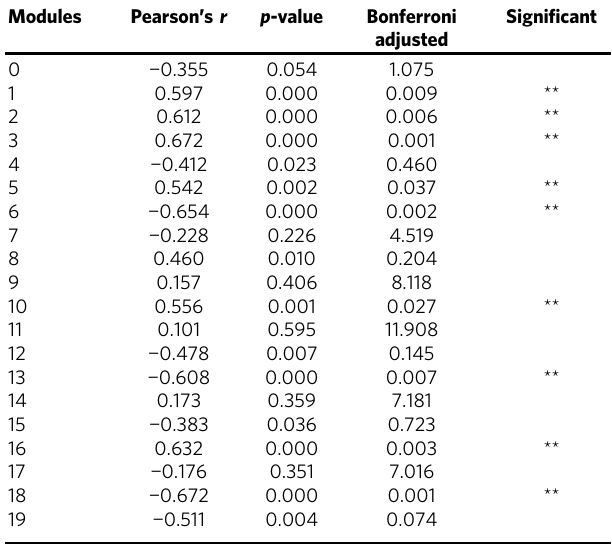
Table 1 Tabulated summary of Pearson correlation coef fi cients between the modules identi fi ed with spectral co-clustering and proximity to tumour, to three signi fi